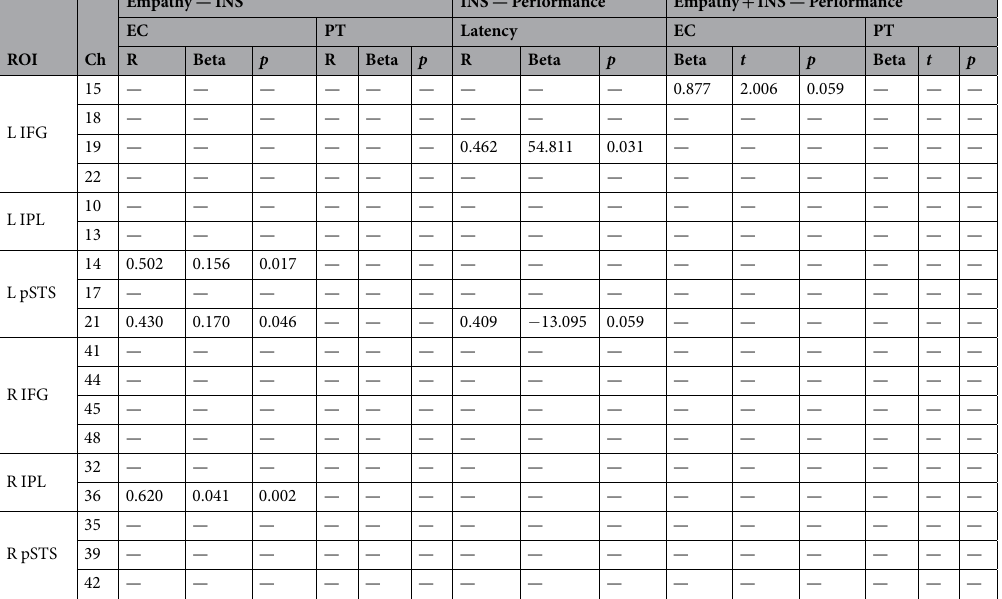
— — — — — 45 — — — — — — — — — — — — — — — 48 — — — — — — — — — — — — — — — 32 — — — — — — — — — — — — — — — R IPL 36 0.620 0.041 0.002 — — — — — — — — — — — — 35 — — — — — — — — — — — — — — — R pSTS 39 — — — — — — — — — — — — — — — 42 — — — — — — — — — — — — — — — Table 3. Linear regression results in the cooperation condition. Note: INS, inter-brain neural synchronization. EC, empathic concern; PT, perspective taking. L, left; R, Right. IFG, inferior frontal gyrus; IPL, inferior parietal lobule; pSTS, posterior superior temporal